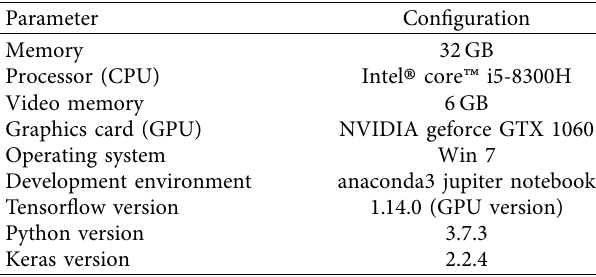
Table 1: Experimental hardware and software environment confguration.